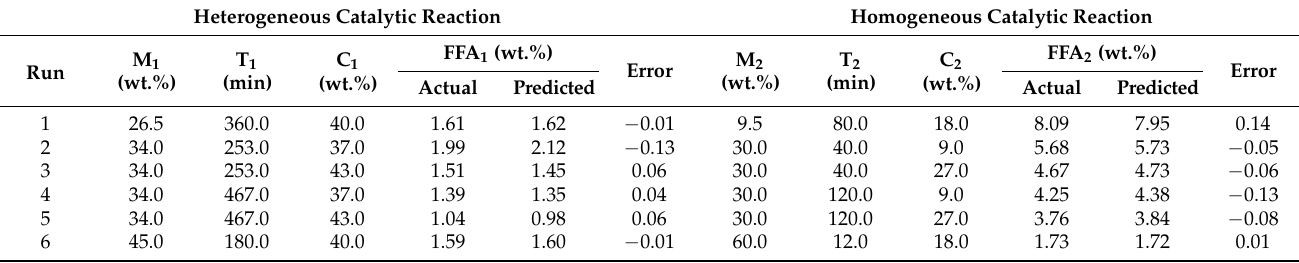
Table 2. Design of experiment and results of the free fatty acid content from the batch process. Heterogeneous Catalytic Reaction Homogeneous Catalytic